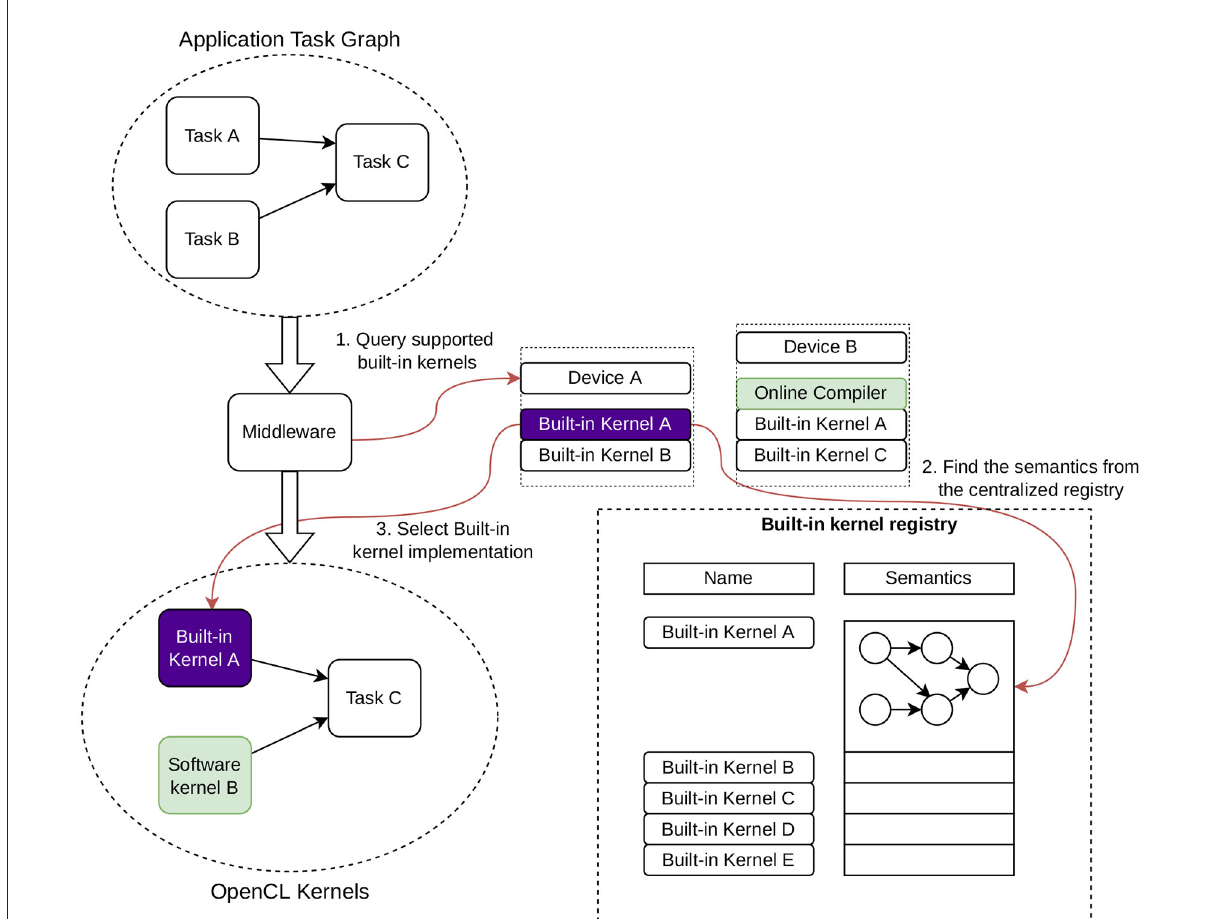
FIGURE3 Task graph lowering by a middleware software component. The middleware queries the available devices for built-in kernel implementations and lowers the task graph to an OpenCL “task graph” implemented with kernels and event dependencies. It accesses the static built-in kernel registry to match the semantics of the built-in kernel to the input graph